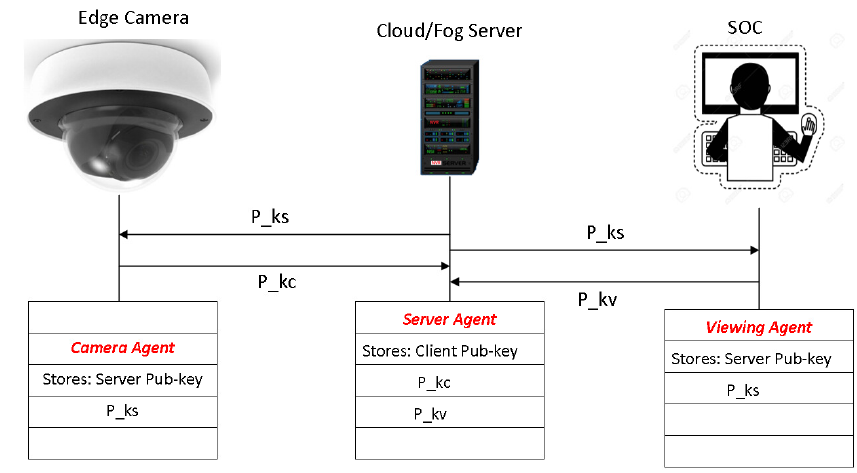
Figure 9. Client-server based key distribution management comprising three agents, namely camera- agent, server-agent, and viewing-agent.